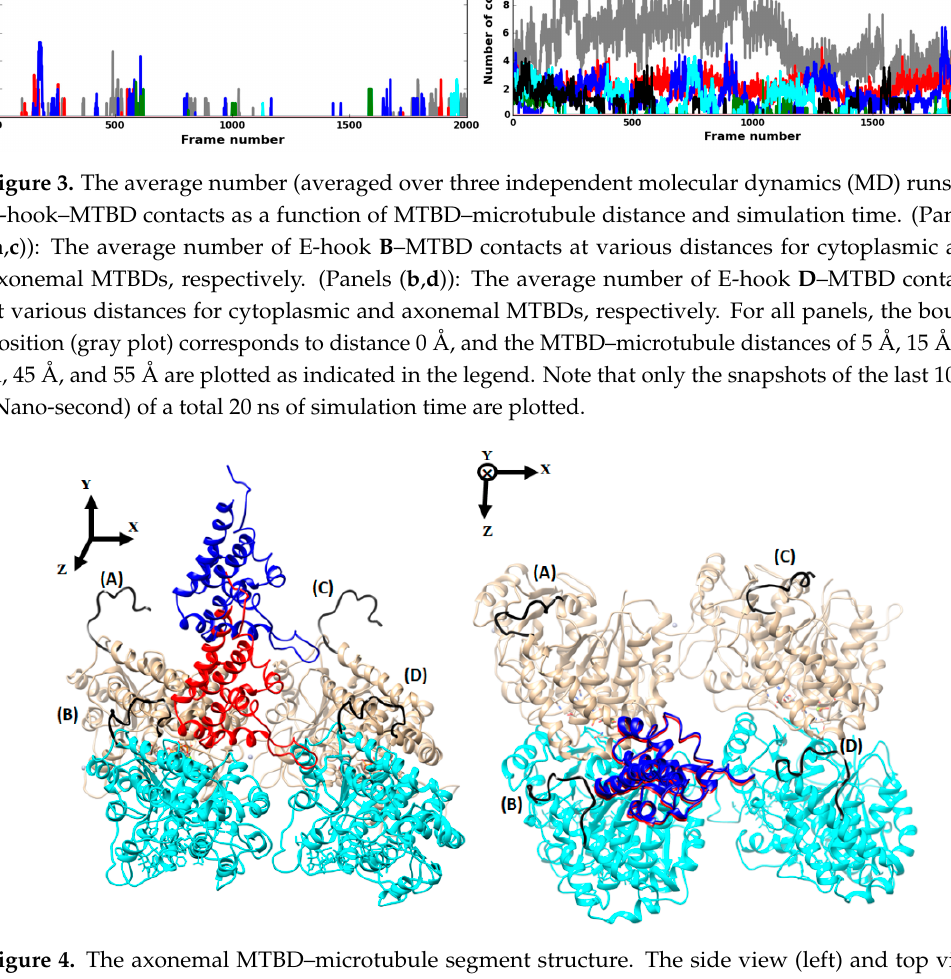
Figure 4. The axonemal MTBD–microtubule segment structure. The side view (left) and top view (right) of two tubulin dimers and an MTBD in the crystallographic position (red) and at a distance of 35 Å (blue). In our structure, we refer to the E-hooks as chains A , B , C , and D, where B and D are β - tubulin (cyan) E-hooks, and A and C are the corresponding α -tubulin (brown) E-hooks. All four E- hooks presented in the structure are labeled according to the chain letter of the corresponding tubulin.